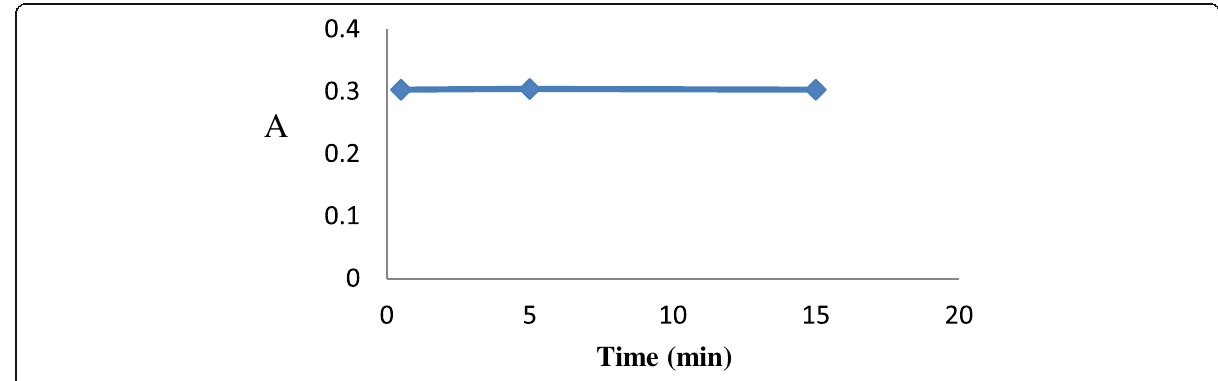
Fig. 7 Effect of reaction time on the complex formation